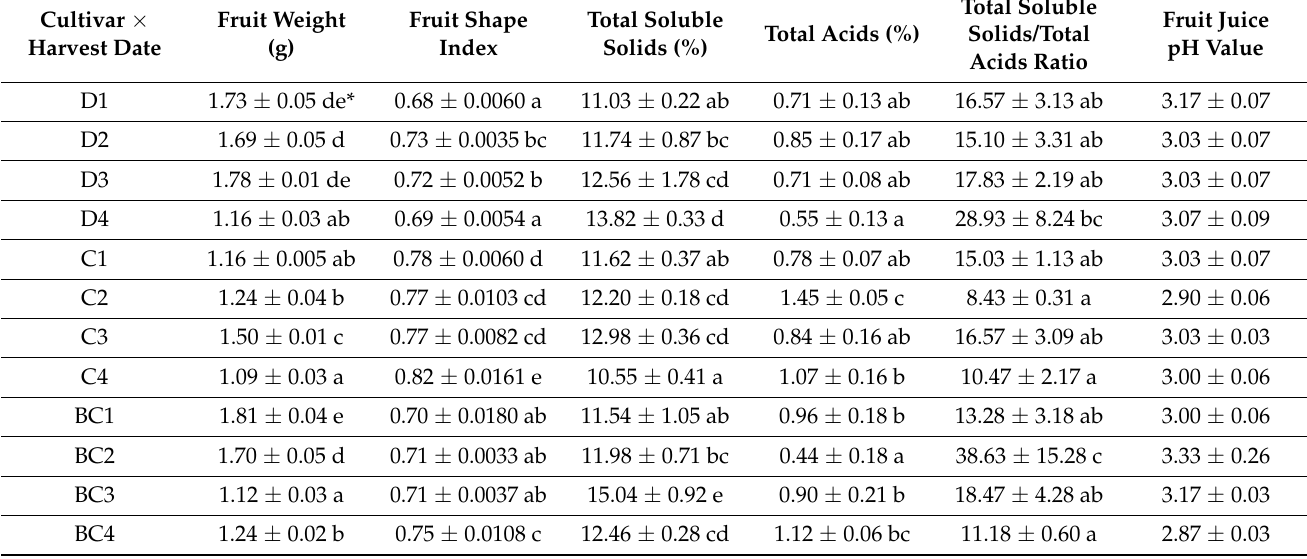
Table 4. Pomological traits in three different blueberry cultivars at four harvest